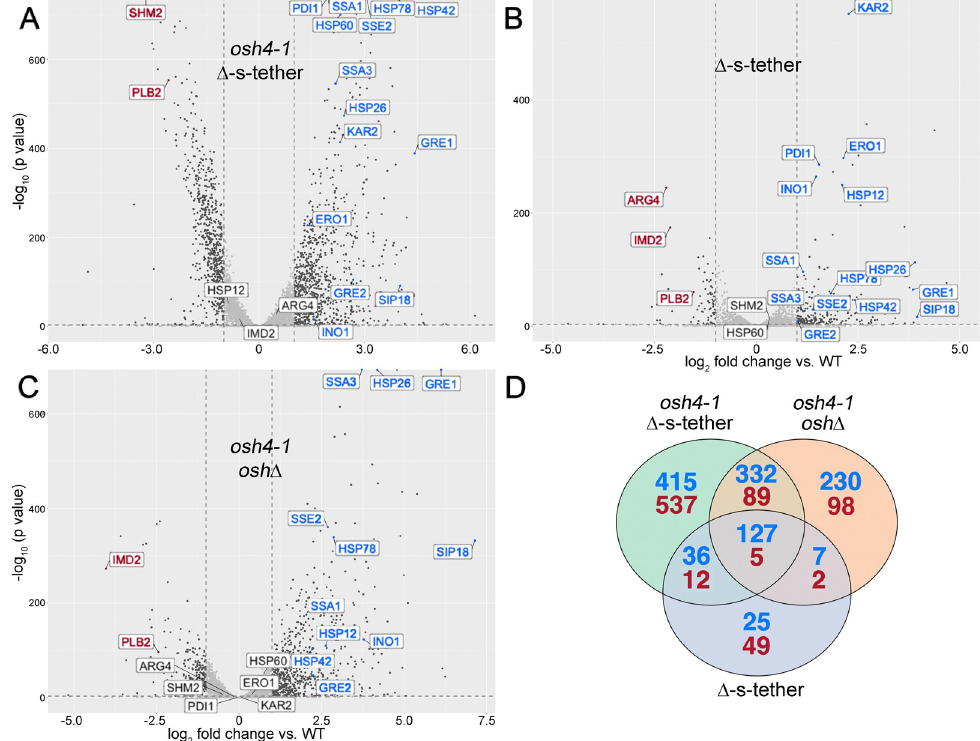
Fig 4. Transcriptomic profiles of osh4-1 ts Δ -s-tether, Δ -s-tether and osh4-1 ts osh Δ cells. Volcano plots showing relative transcript abundance in ( A) osh4-1 ts Δ -s-tether (CBY6031), ( B) Δ -s-tether (CBY5898) and ( C) osh4-1 ts osh Δ (CBY926) cells grown in synthetic minimal media at 37˚C. Plots show log 2 -fold expression change relative to WT (SEY6210) versus the negative log 10 -P value (y-axis). Transcript changes log 2 � or � 1 are shown in black whereas representative stress pathway genes are blue and red, corresponding to induction or repression, respectively. ( D) Venn Diagram showing overlapping subsets of upregulated (blue) or downregulated genes (red) in osh4-1 ts Δ -s-tether, Δ -s-tether and osh4-1 ts osh Δ cells.